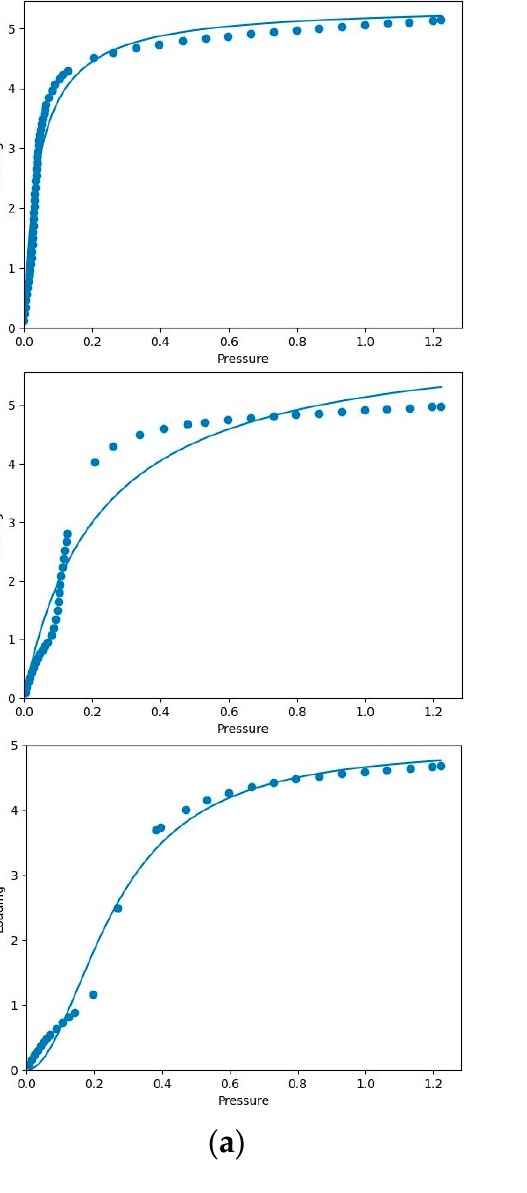
Figure 8. Experimental single-component adsorption isotherms (dot) and Langmuir fitted-isotherms (line): ( a ) CO 2 ; ( b ) CH 4 at 273, 298 and 313 K, respectively.